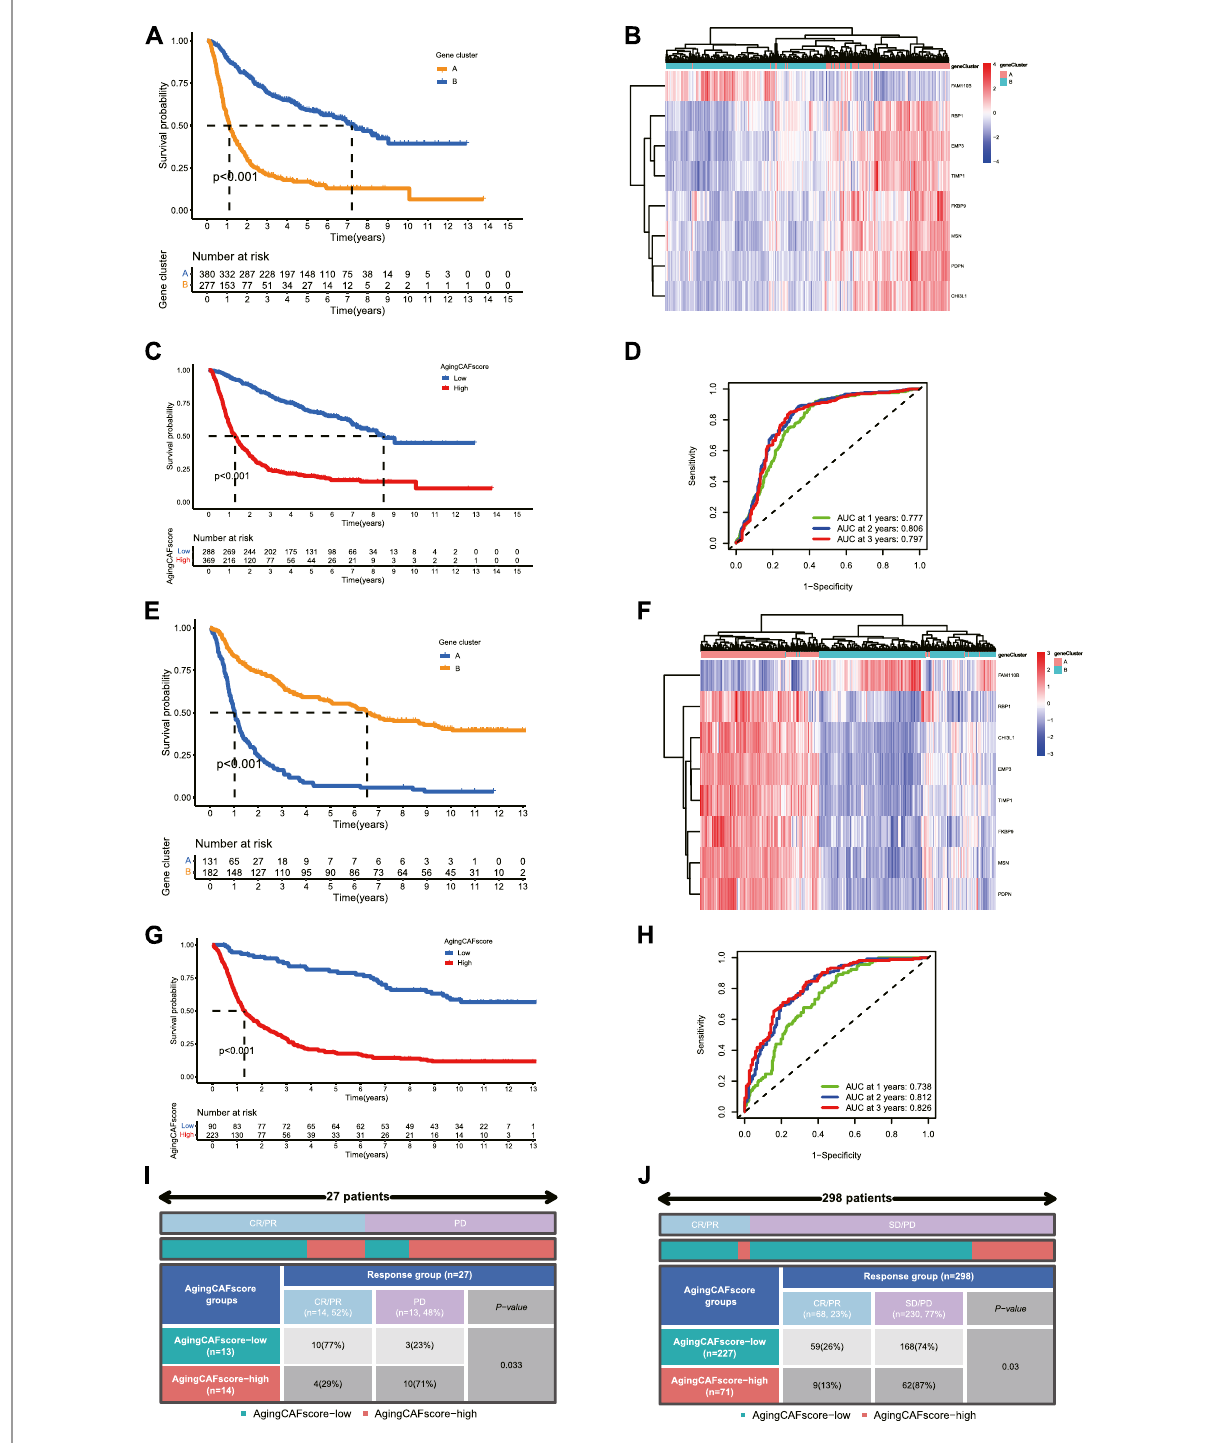
FIGURE 8 ValidationofagingCAF-relatedgenesinexternaldatasets. (A) ComparisonoftheoverallsurvivalbetweengeneclustersAandBinthevalidation cohort (dataset ID: mRNAseq_693). (B) Unsupervised clustering for samples based on the expression of eight featured ACAFRGs in the validation cohort (dataset ID: mRNAseq_693). (C) Comparison of the overall survival between the low- and high-aging CAF score groups in the validation cohort (dataset ID: mRNAseq_693). (D) Time-dependent ROC curves of the aging CAF score in the validation cohort (dataset ID: mRNAseq_693). (E – H) Similarresultswereobtained inanothervalidationcohort(dataset ID:mRNAseq_325). (I) Comparison oftheresponse